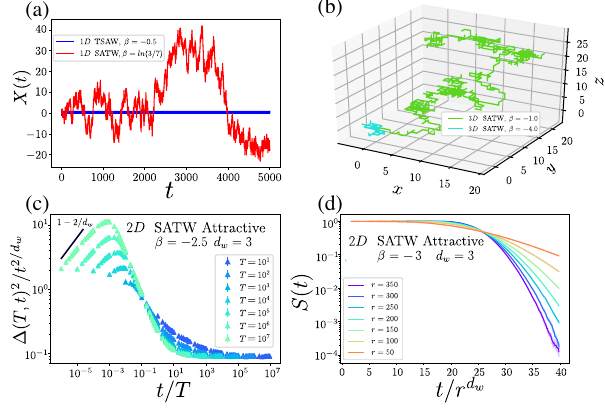
FIG. 2. General properties of attractive self-interacting random walks. (a) Example of a trapped trajectory performed by a 1 d attractive TSAW random walker (blue), compared to a diffusive trajectory of a 1 d attractive SATW random walker (red). (b) For d > 1 , the SATW is subdiffusive for j β j > j β (blue sample c j trajectory) and diffusive for j β j < j β (green sample trajectory). c j ≠ 0 [25]. (c) Aging of the increments Here, d ¼ 3 , and thus j β c j 3 for d ¼ 2 ) normalized by the for the subdiffusive SATW ( d w ¼ expected subdiffusive scaling at long times. Each curve corre- sponds to a fixed value of T . Note that the increments are diffusive for t ≪ T . (d) In the subdiffusive regime, the SATW performs an extremely compact exploration of space: The survival probability S ð t Þ decays faster than any power law ( θ ¼ ∞